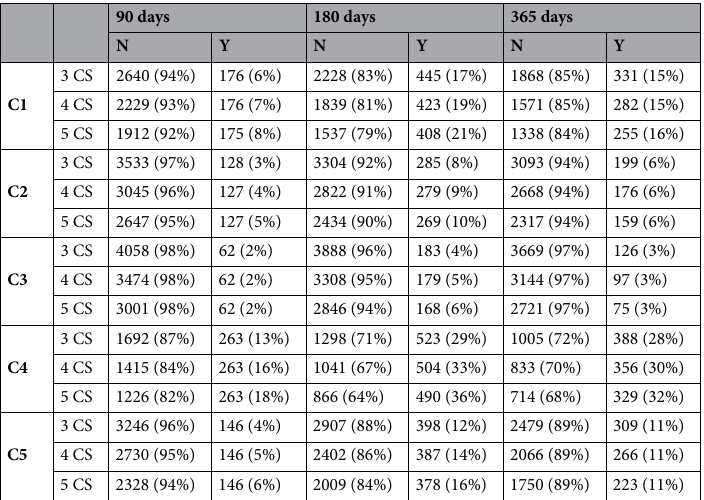
Table 5. Initial class distribution concerning each target endpoint and time window, after creating the learning examples considering 3, 4, and 5 consecutive snapshots of patient historical assessments. C1, need for NIV; C2, need for an auxiliary communication device; C3, need for PEG; C4, need for a caregiver, and C5, need for a